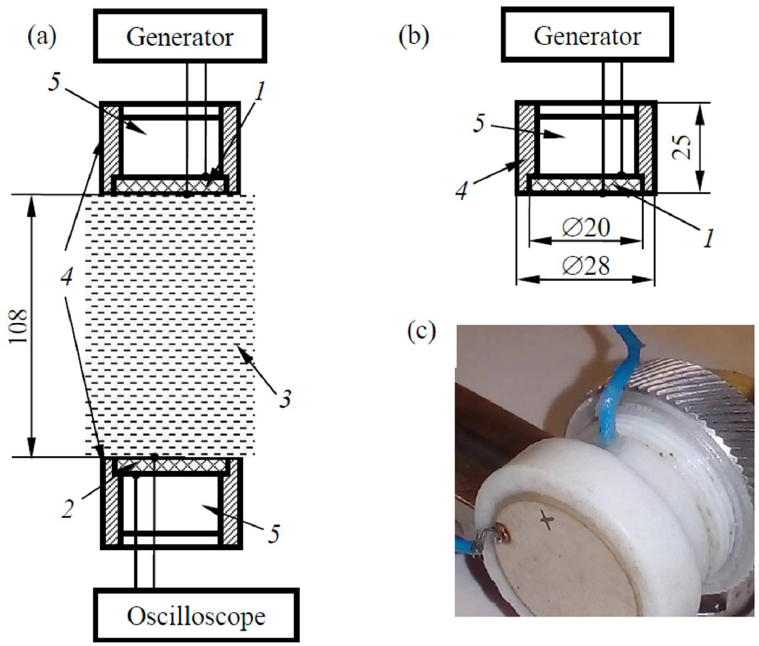
Figure 1. Experimental setup: ( a ) pattern, ( b ) diagram, and ( c ) photo of the piezoelectric transducer.